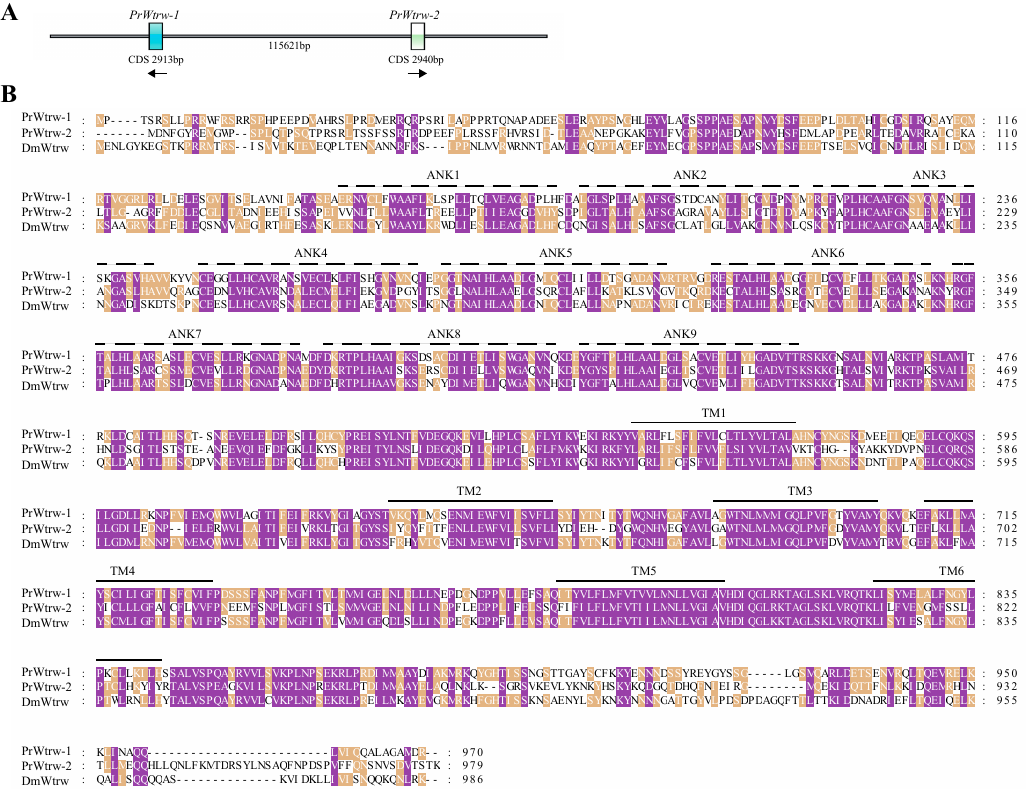
Figure 5. Sequence analysis of two PrWtrw genes. ( A ) Duplication diagram of the PrWtrw gene. Length of two coding sequences (CDSes) and interval length of two genes were shown as the figure. Arrows showed the direction of gene transcription. ( B ) Multiple sequence alignment deduced for PrWtrw-1, PrWtrw-2 and DmWtrw. Ankyrin repeats were indicated with dotted lines and marked as ANK1–2. Transmembrane regions were indicated with solid lines and marked as TM1–6. The protein sequences used for multiple sequence alignment were in the attached fasta file.